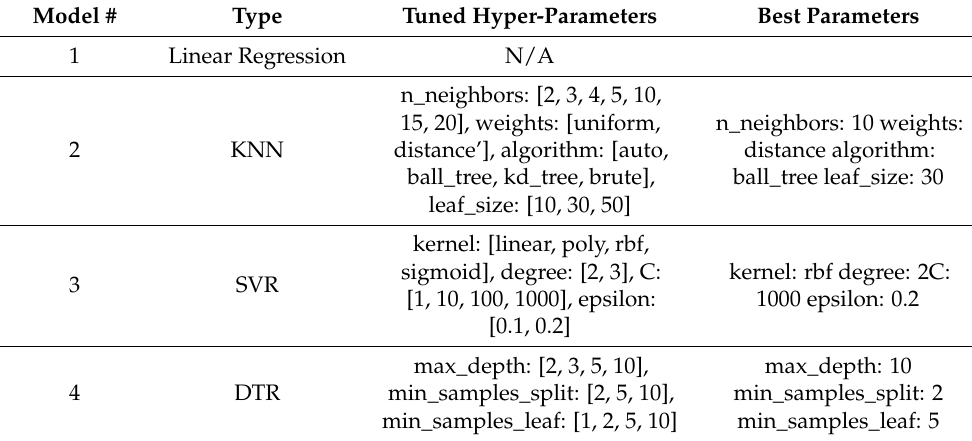
Table 8. Models selected for the prediction of pressure for water/n-octane.